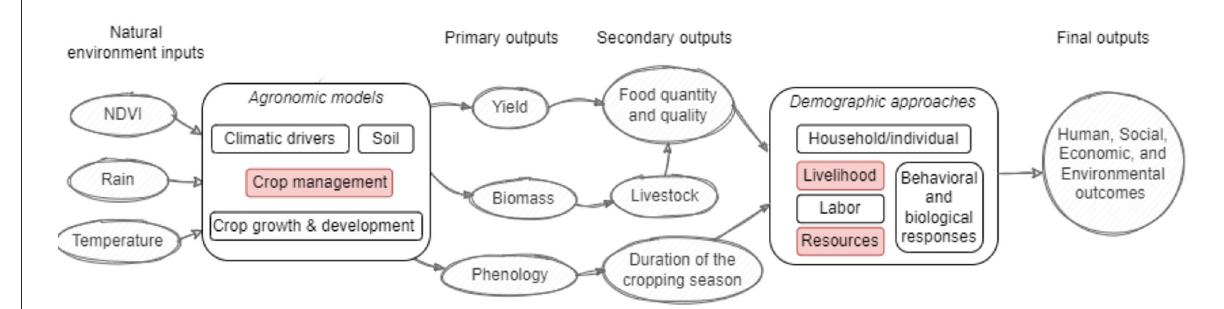
FIGURE2 Traditional demographic approaches integrated with agronomic models. Inputs and outputs are represented by circles; models are represented by squares. Boxes within the models represent model components. Agronomic model components are a simplification of Keating et al.